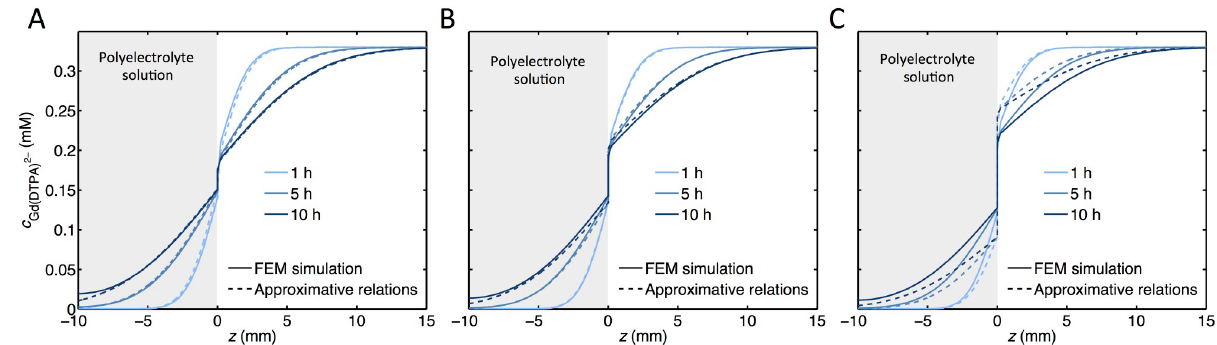
Fig 5. Comparison of concentration profiles from FEM simulations and approximate analytic expressions. The concentration of Gd(DTPA) 2 − vs z from FEM simulations (solid lines) and from Eqs 18 and 19 and Equation W in S1 Appendix (dashed lines) for a polyelectrolyte solution with an FCD of (A) -50 mM, (B) -108 mM and (C) -150 mM. Parameters used in the calculations A; D ¼ (cid:0) 0 : 041 RT , D m corr ¼ (cid:0) 0 : 125 RT . B; values in Table 1. C; D D m corr Cl (cid:0) G : 2 (cid:0) D m corr ¼ (cid:0) 0 : 318 RT . G : 2 (cid:0)